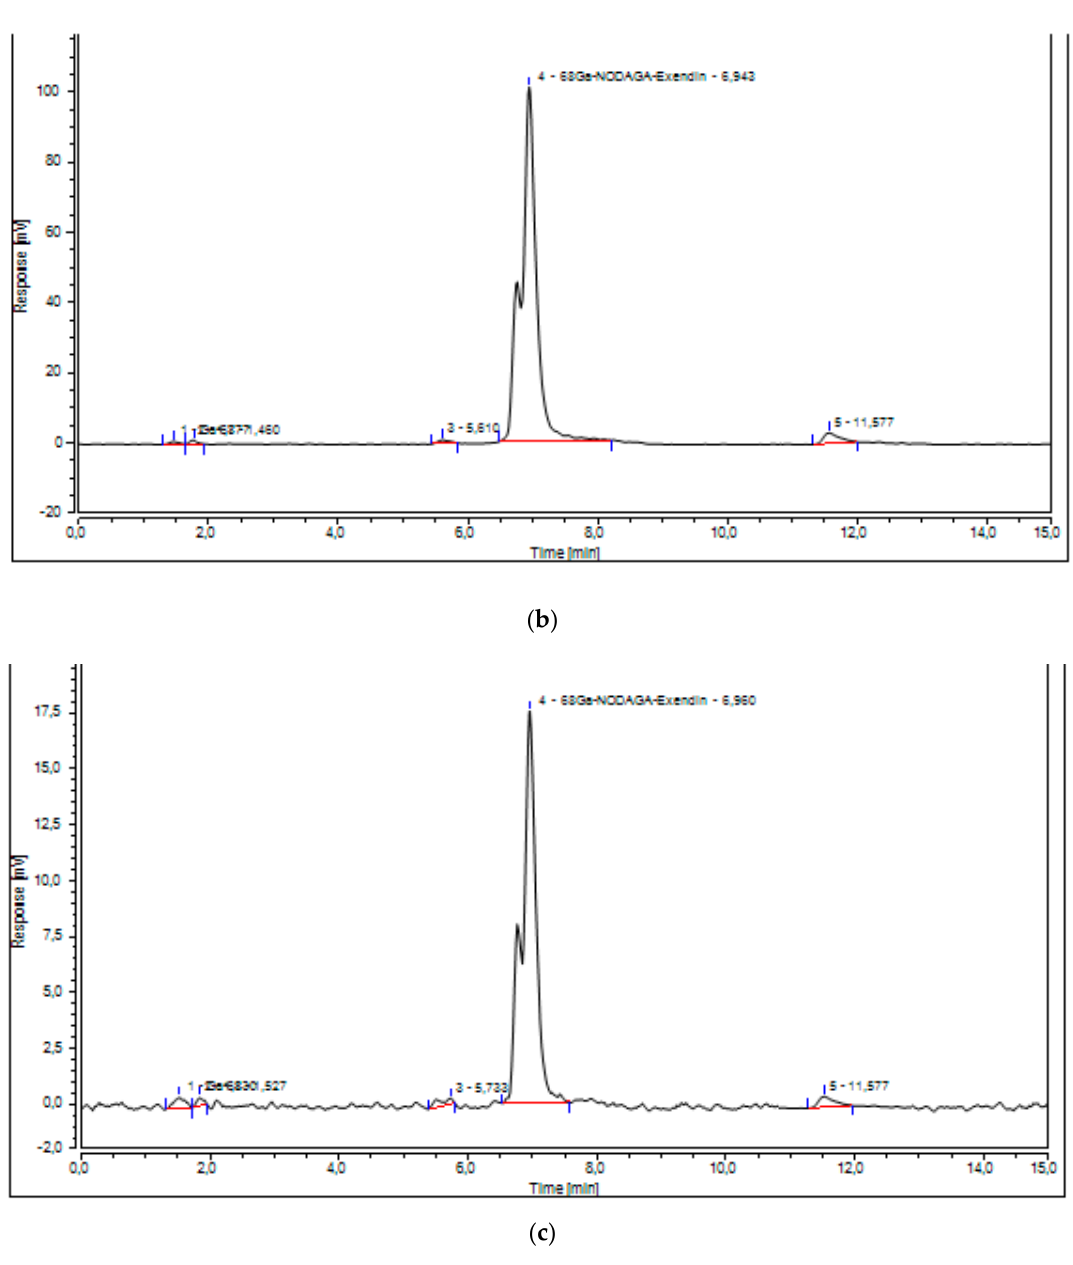
Figure 6. Stability of [ 68 Ga]Ga-NODAGA-exendin-4 at T0 ( a ), T2 h ( b ), and T4 h ( c ).